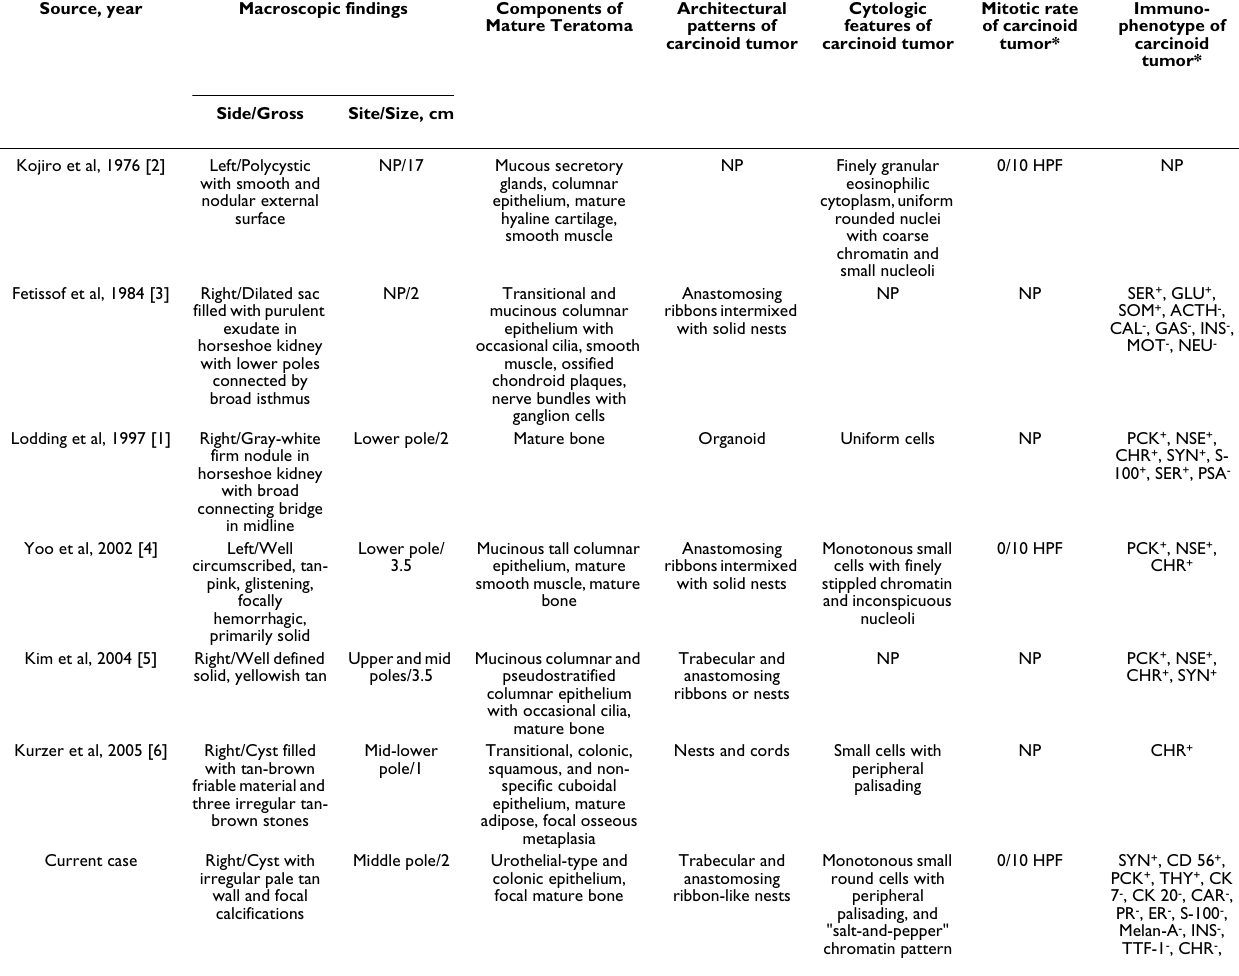
Table 2: Pathologic characteristics of primary carcinoid tumor arising within mature teratoma of the kidney Source,